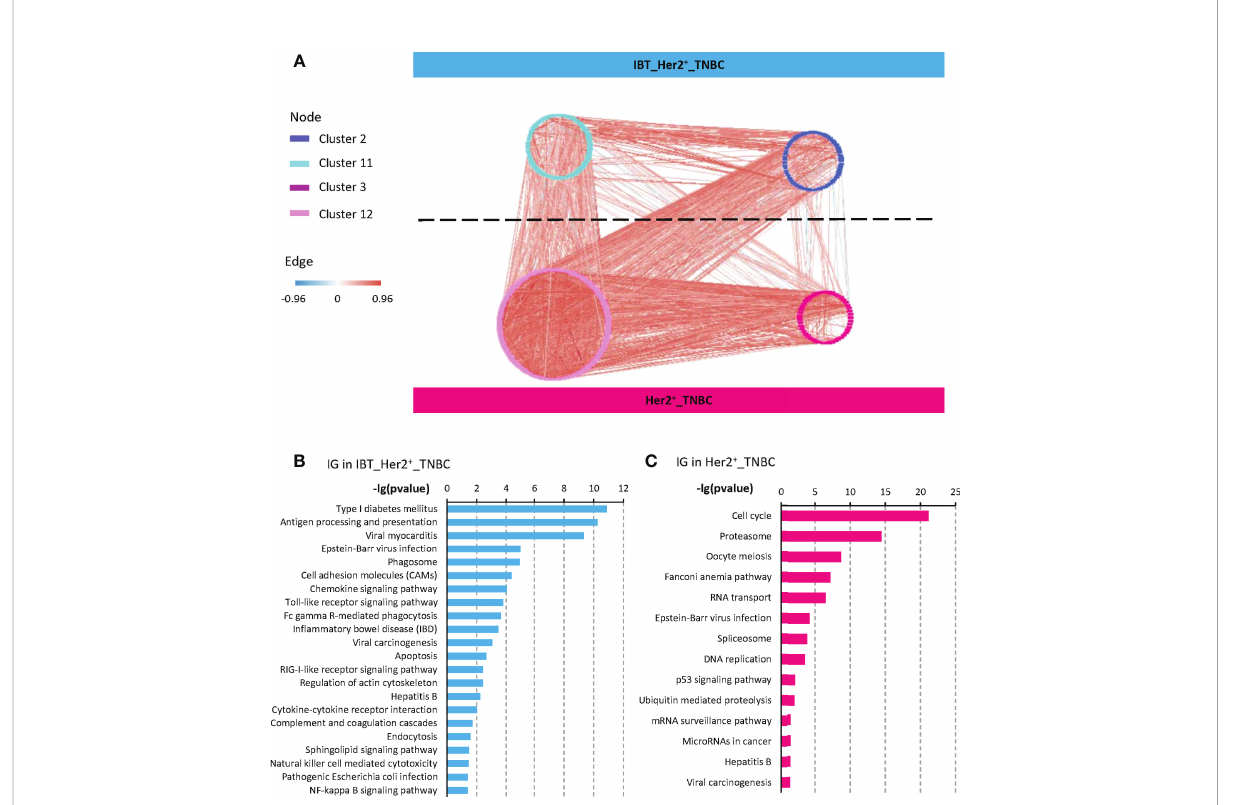
FIGURE 3 Interface genes were detected by protein interaction network. (A) A NP network generated between the four gene clusters from IBT_Her2 + _TNBC module (clusters 2 and 11) and Her2 + _TNBC module (clusters 3 and 12). Nodes represent genes, red edges represent positively correlated interactions between genes, and blue edges represent negatively correlated interactions. (B, C) KEGG terms enriched in interface genes (IG) from IBT_Her2 + _TNBC module and Her2 + _TNBC